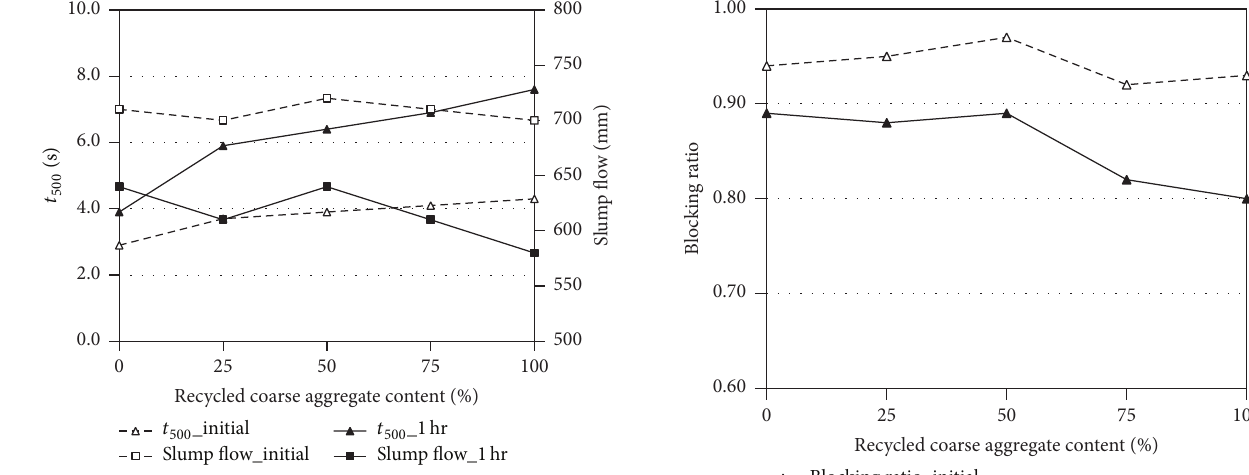
Figure 3: Effect of RCA content on slump flow and 𝑡 500 times for SCC.